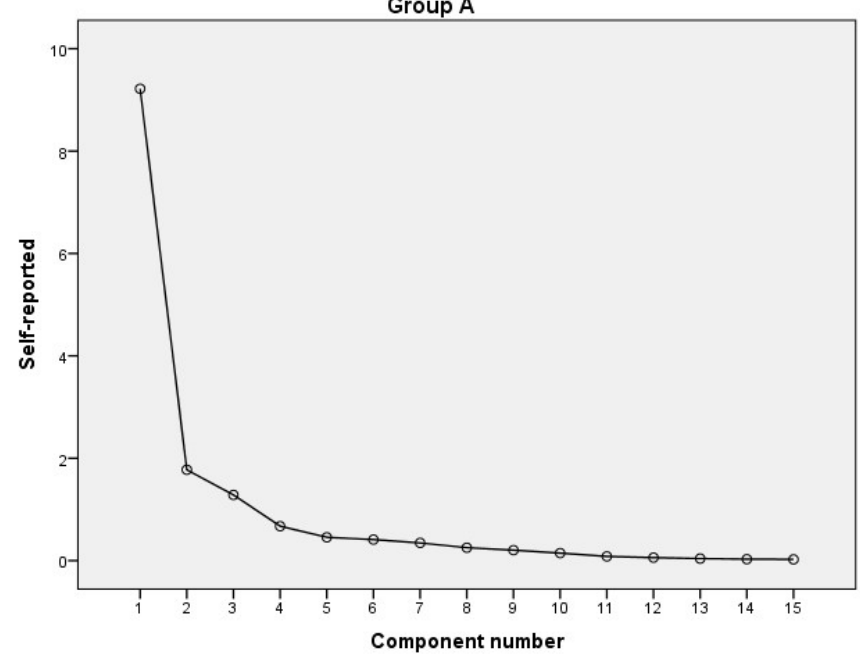
Figure 1. Graphical representation of the intensity of self-reported values for MPIS. Table 4. The factors of the composition of the MPIS and the explained